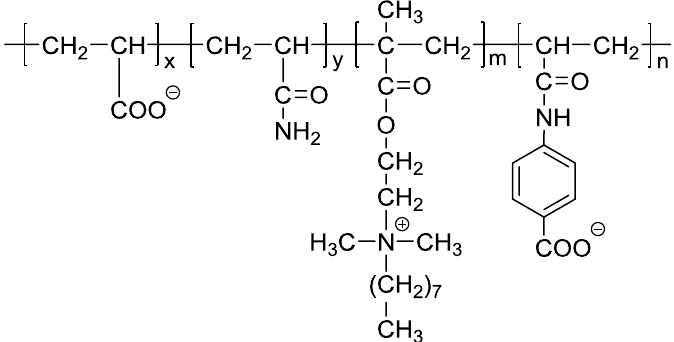
Figure 8. The molecular structure of HAHPAM (x = 25.0 wt%, y = 74.85 wt%, m = 0.1 wt%, n = 0.05